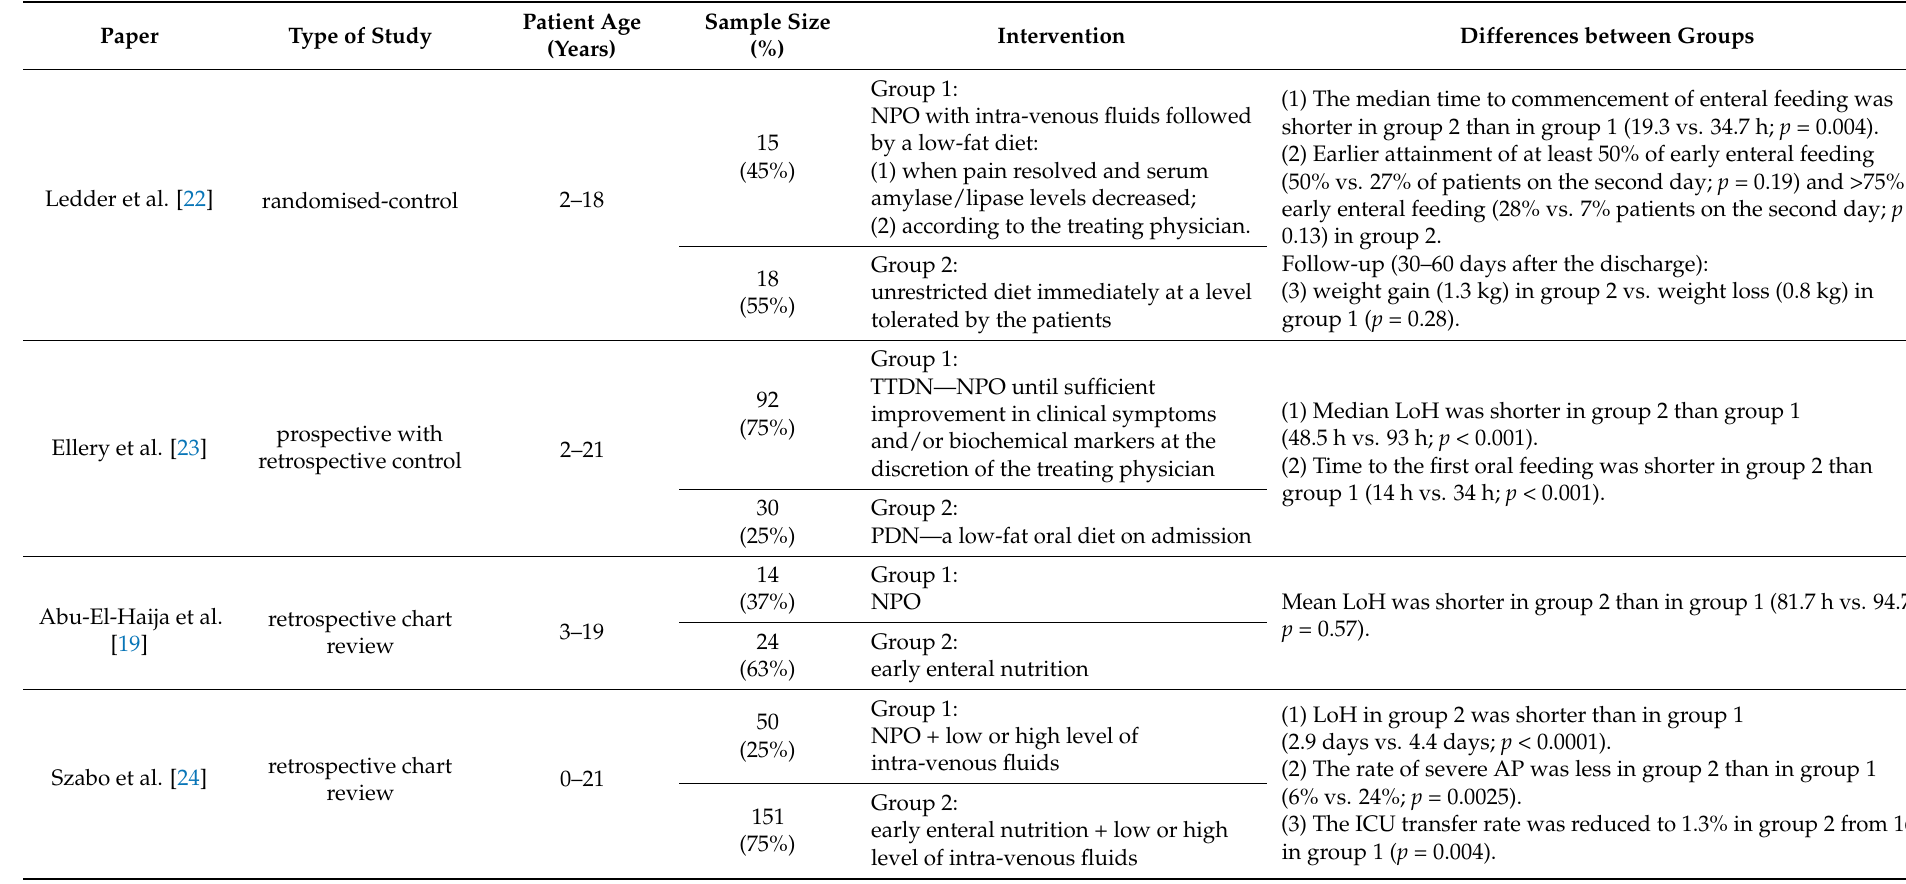
Table 1. Characteristics of the